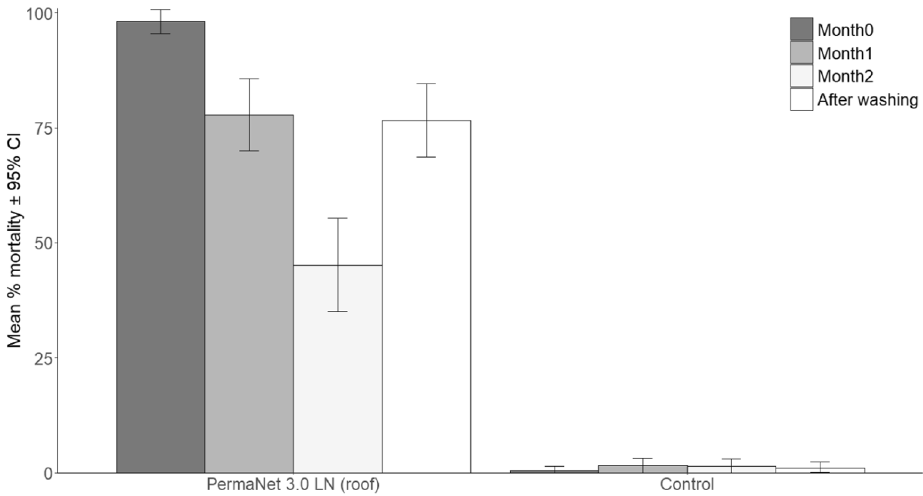
Figure 4. Residual activity in ET bioassays of netting samples from PermaNet 3.0 (roof) LN tested against pyrethroid resistant Anopheles gambiae mosquitoes from Bouake with 1 h exposure and 24 h recovery. Error bars indicate the 95% confidence intervals. “After washing” corresponds to Month2 net samples washed 1X.